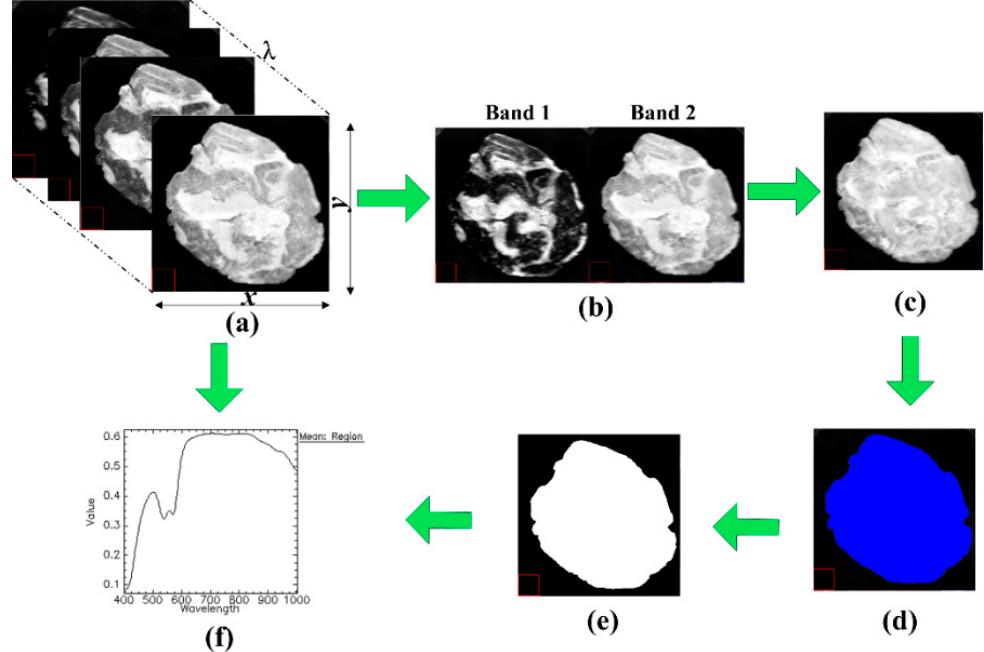
Figure 1. Steps for image segmentation. ( a ) calibrated hyperspectral images; ( b ) band images with low and high reflectance intensity (415 nm and 800 nm); ( c ) resulted image using band math function; ( d ) ROI identification by thresholding; ( e ) mask establishment; and ( f ) spectra extraction.